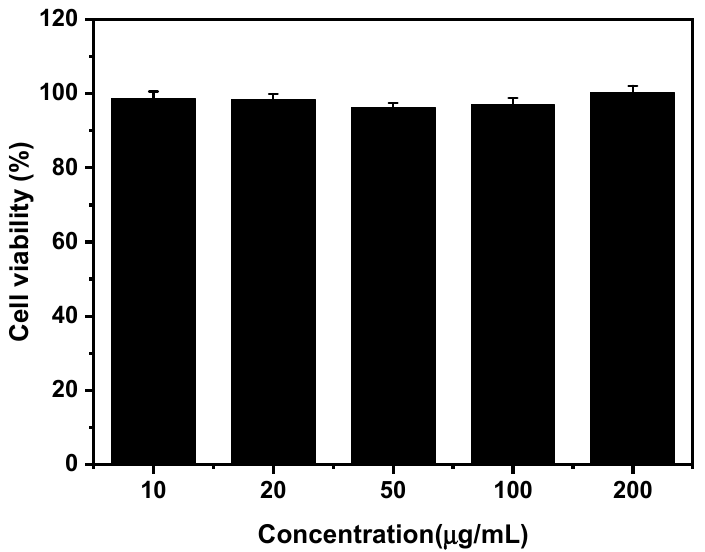
Figure 7. The cell viability of 3T3-L1 cells incubated with different concentrations of amino-Fe- PDANPs for 24 h.